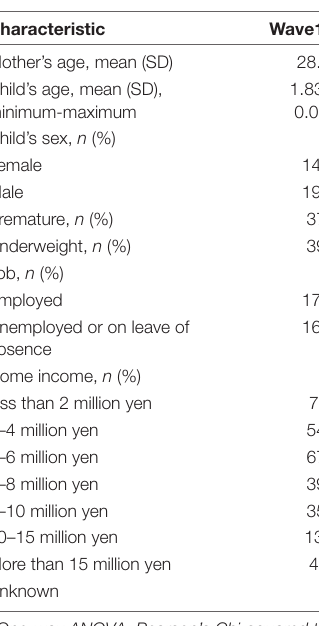
TABLE 1 | The sociodemographic composition of the